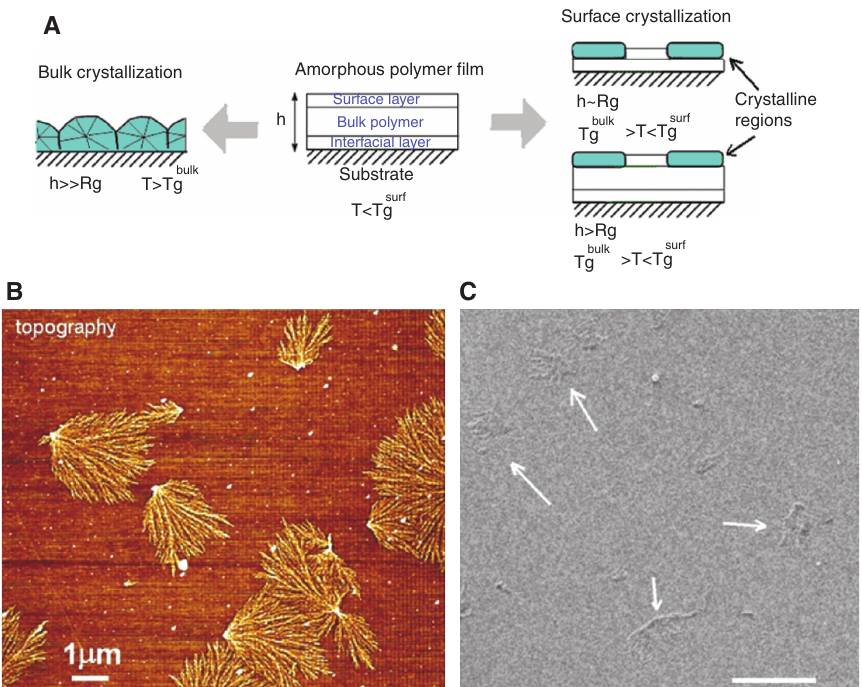
Figure 7 (A) Bulk vs. surface crystallization phenomena in a crystallizable polymer film under condition of geometrical confinement (film thickness is below 200 nm and comparable with the characteristic size of polymer chains –the radius of gyration); (B) AFM image of PET dendritic crystals grown on the surface of otherwise amorphous film (40 nm thickness); (C) the same structure visualized by HIM (200 nm film thickness). Arrows point several dendritic PET crystals. Scale bar 1 μ